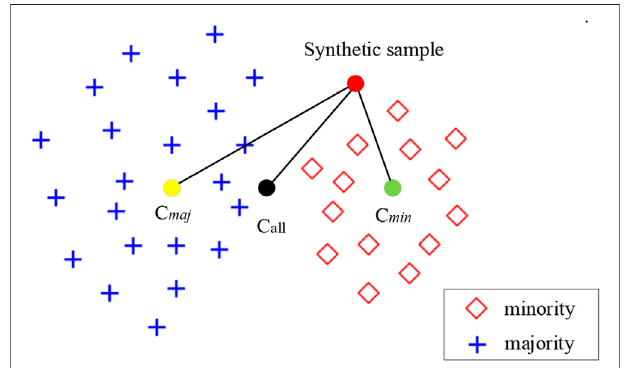
FIGURE 4 | Validation of the new synthetic feature